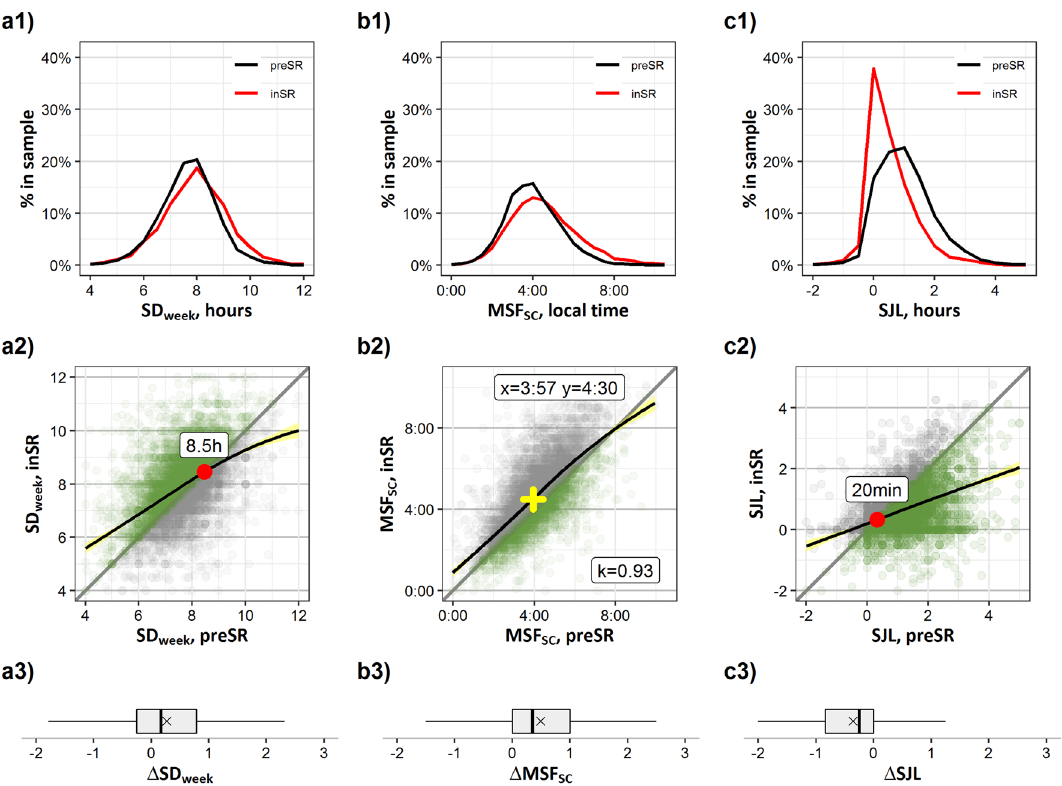
Figure 1. Social restriction-induced changes ( preSR → inSR ) in sleep–wake behavior in the general sample. ( a1 – c1 ) Distributions of SD week , MSF sc , and SJL preSR (black line) and inSR (red line), percent from group total. ( a2 – c2 ) Scatterplots of sleep duration, SD week (hours), corrected mid-sleep time on free days, MSF sc (chronotype, local time), and social jetlag, SJL (hours), preSR (x axis) vs. inSR (y axis). Each dot represents an individual participant, overlapping dots are coded by color intensity. Diagonal line designates no restriction-induced change in parameter. Green—increase/advance, grey—decrease/delay. Black line—LOESS regression lines illustrate the relationship between the parameter values preSR (x-axis) and the smoothed parameter values inSR (y-axis), pointwise 95% confidence intervals are visualized by bands shaded in yellow. Red dot—intersection point between the diagonal and the LOESS line. Yellow cross coordinates—means of MSF sc preSR and inSR ; k—slope of the tangent for the LOESS regression line at the point of mean MSF sc preSR. ( a3 – c3 ) Boxplots of individual differences (∆, hours) in SD week , MSF sc and SJL. Positive values—increase in SD week , delay in MSF sc . Negative values—decrease in SJL. Whiskers—max and min values, box borders—75th and 25th percentiles, line through the box—median,